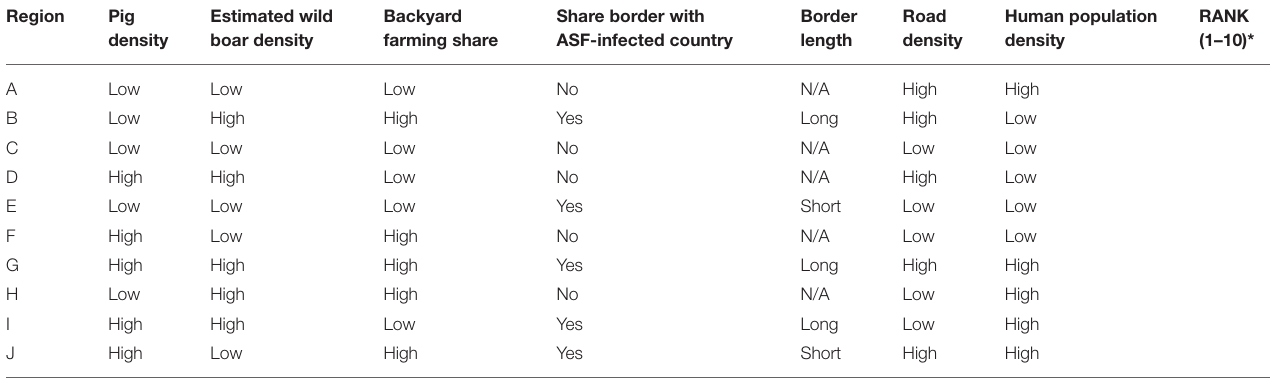
TABLE 1 | A hypothetical African swine fever (ASF)-free country was divided into 10 districts that were characterized in terms of the risk for an ASF introduction using a list of epidemiological factors hypothesized to influence the risk and a factorial design. Region Pig